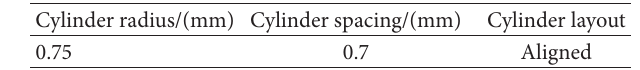
Figure 7: Methane conversion along sectional position with cylin- der spacing of 0.7 mm ( ◼ ), 0.9 mm ( e ), and 1.1mm ( 󳵳 ) in steady state. Table 7: The finalized structure of microchamber.